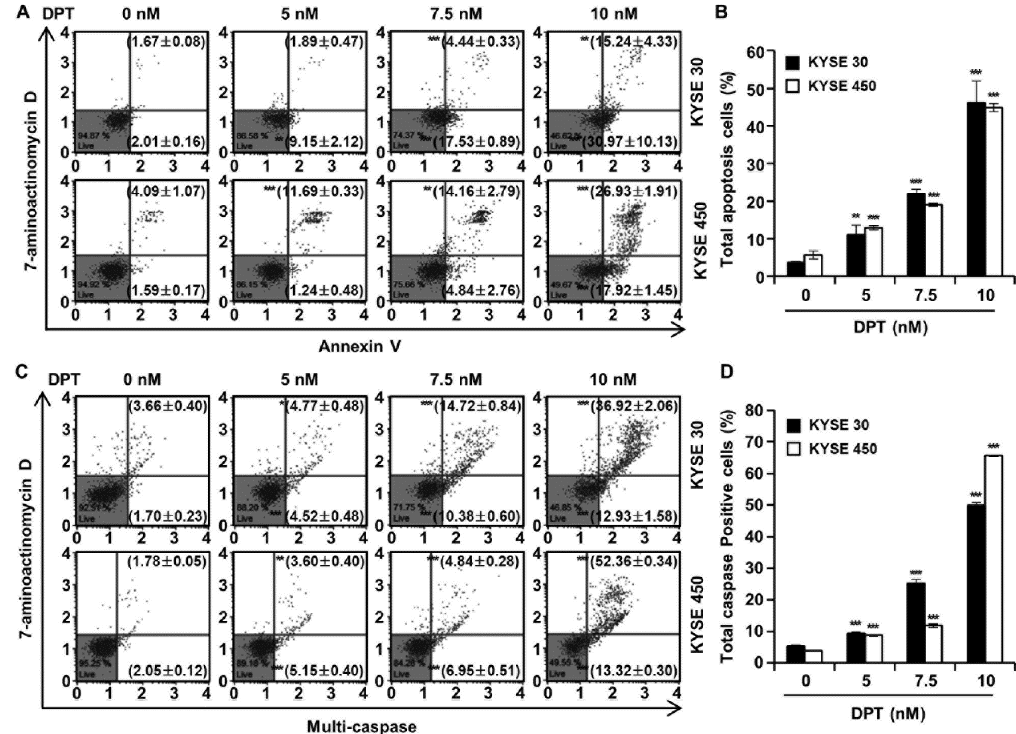
Figure 4. Effect of DPT on apoptosis and multi-caspase activity in ESCC cells. KYSE 30 and KYSE 450 cells were treated with DPT at 0, 5, 7.5, and 10 nM for 48 h. ( A , B ) Range of apoptosis decided by quantification of annexin V/7-aminoactinomycin D (7-AAD) stained cells. ( C , D ) Multi-caspases